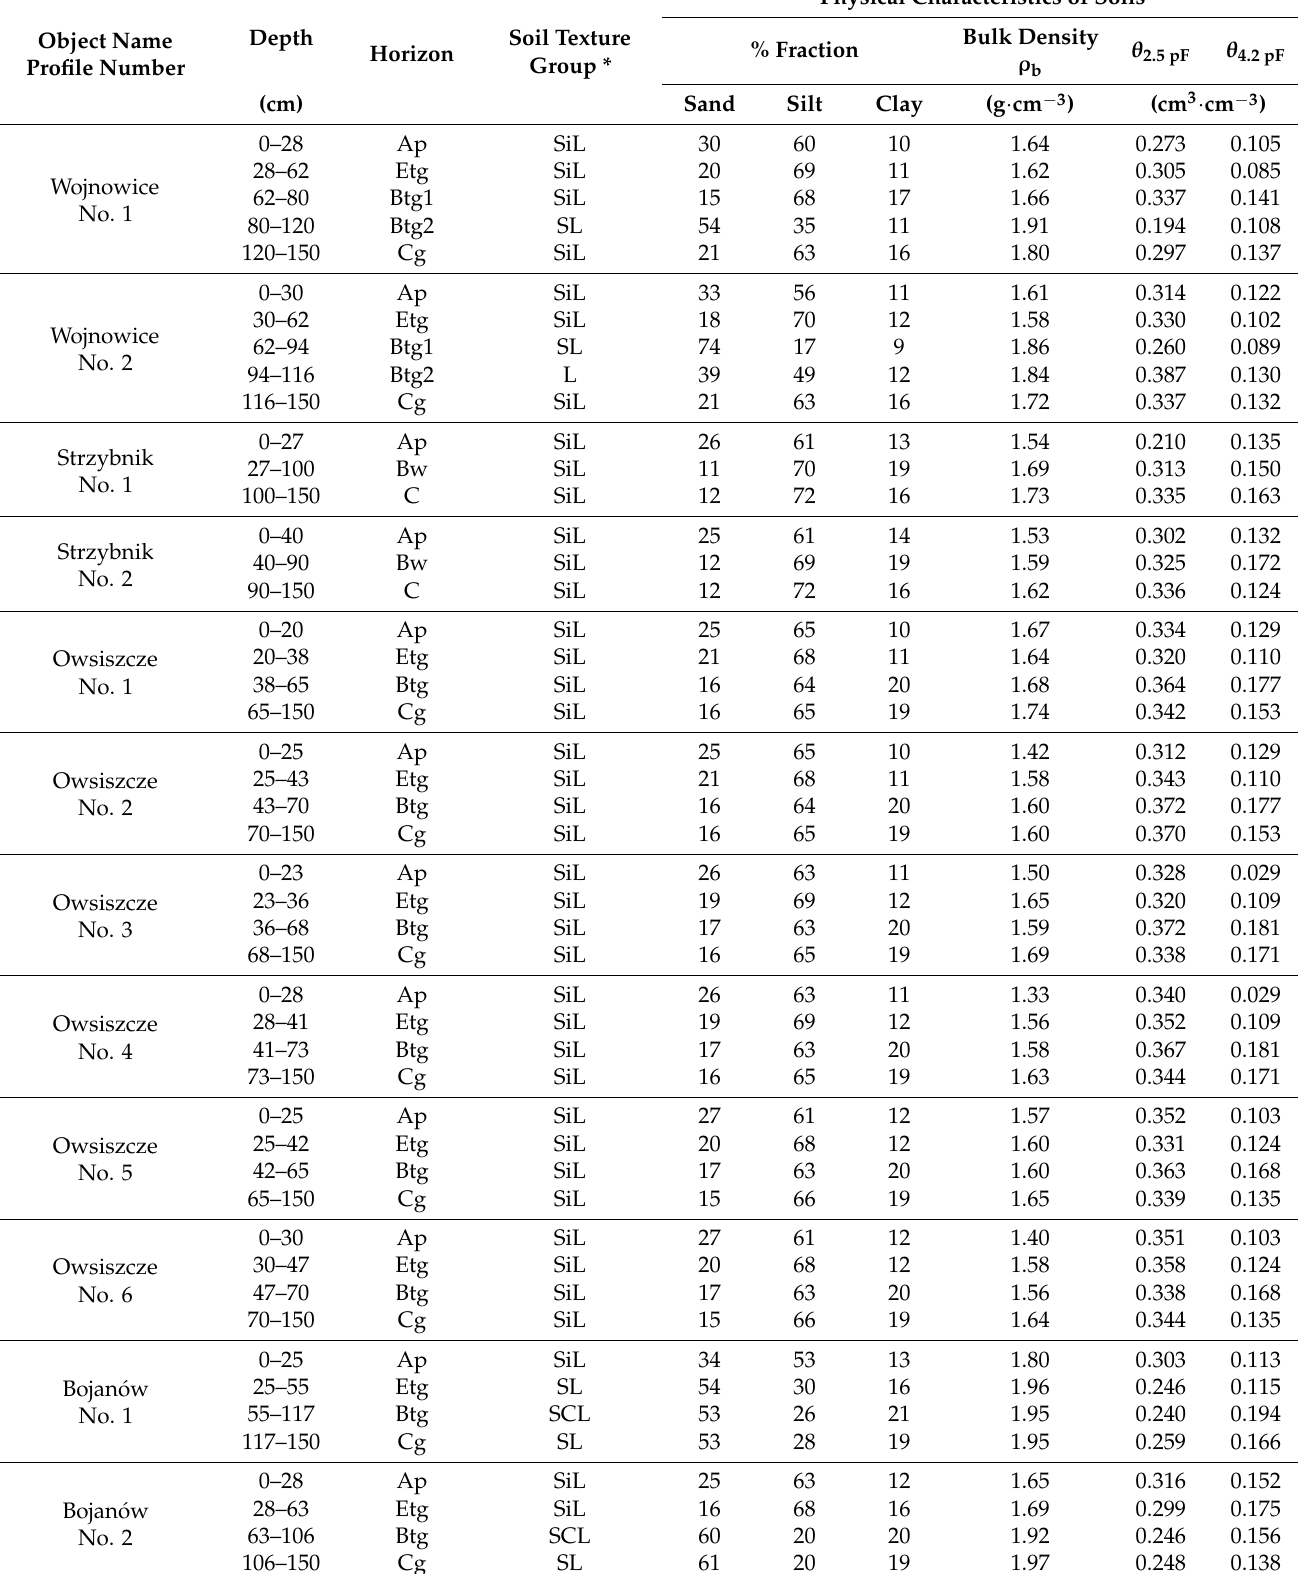
Table 2. Selected soil physical properties over all